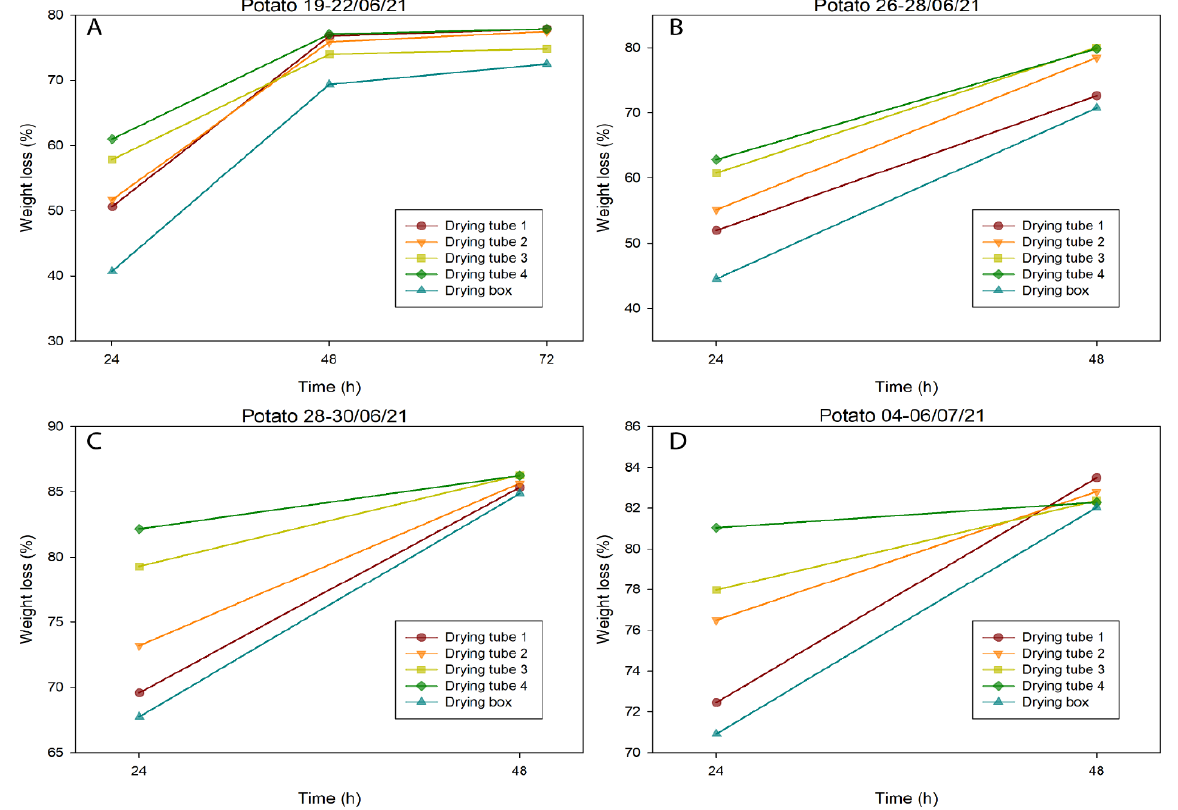
Figure 6. Potato’s daily average weight loss (% of initial fresh weight for each drying tube and the drying box for the period of ( A ) 19/06–22/06/2021, ( B ) 26/06–28/06/2021, ( C ) 28/06–30/06/2021, and ( D ) 04/07–06/07/2021.